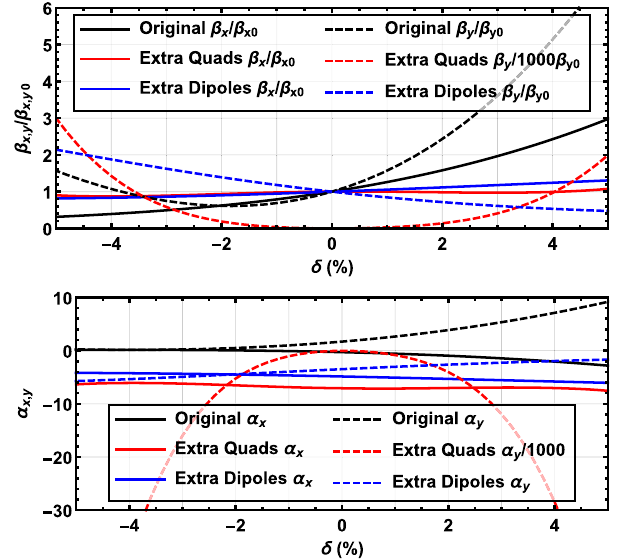
FIG. 15. Chromatic dependence of the beta (top) and alpha (bottom) functions at the end of BC1 for the original, fixed lattice (black), additional quadrupole (red) and additional dipole (blue) solutions.